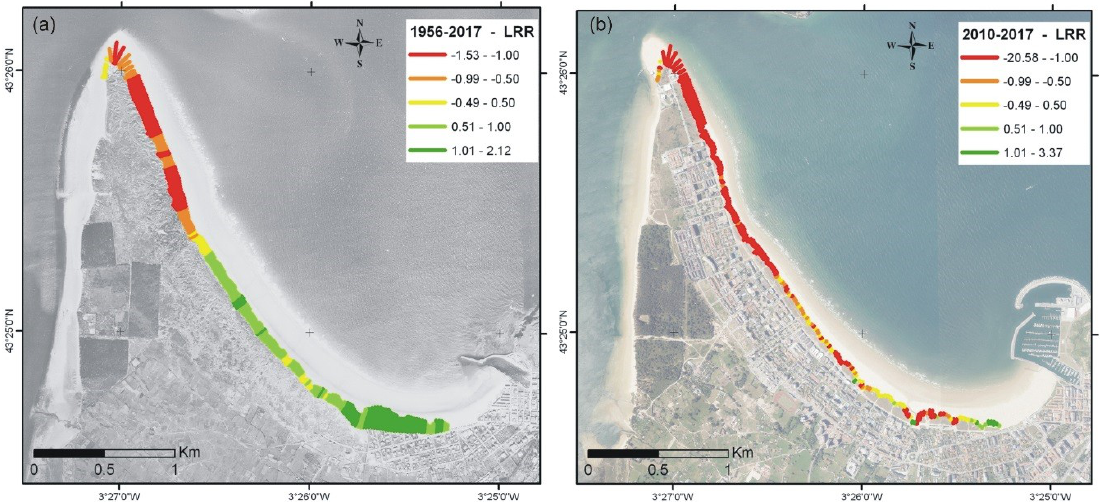
Figure 3. Digital Shoreline Analysis System (DSAS) results for the Linear Regression Rate (LRR) statistical parameter (m year −1 ) at the Laredo dune system, for the entire time period ( a ) and post-storm period ( b ).